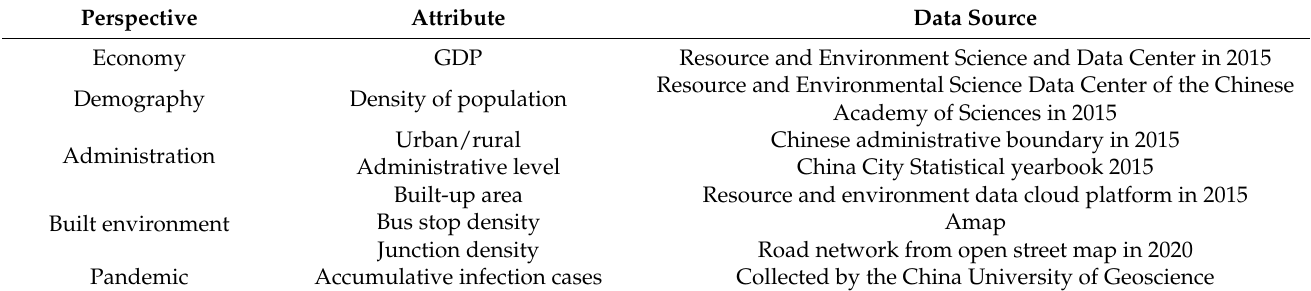
Table 3. Grid-cell attributes and data sources for the mean decrease Gini approach.